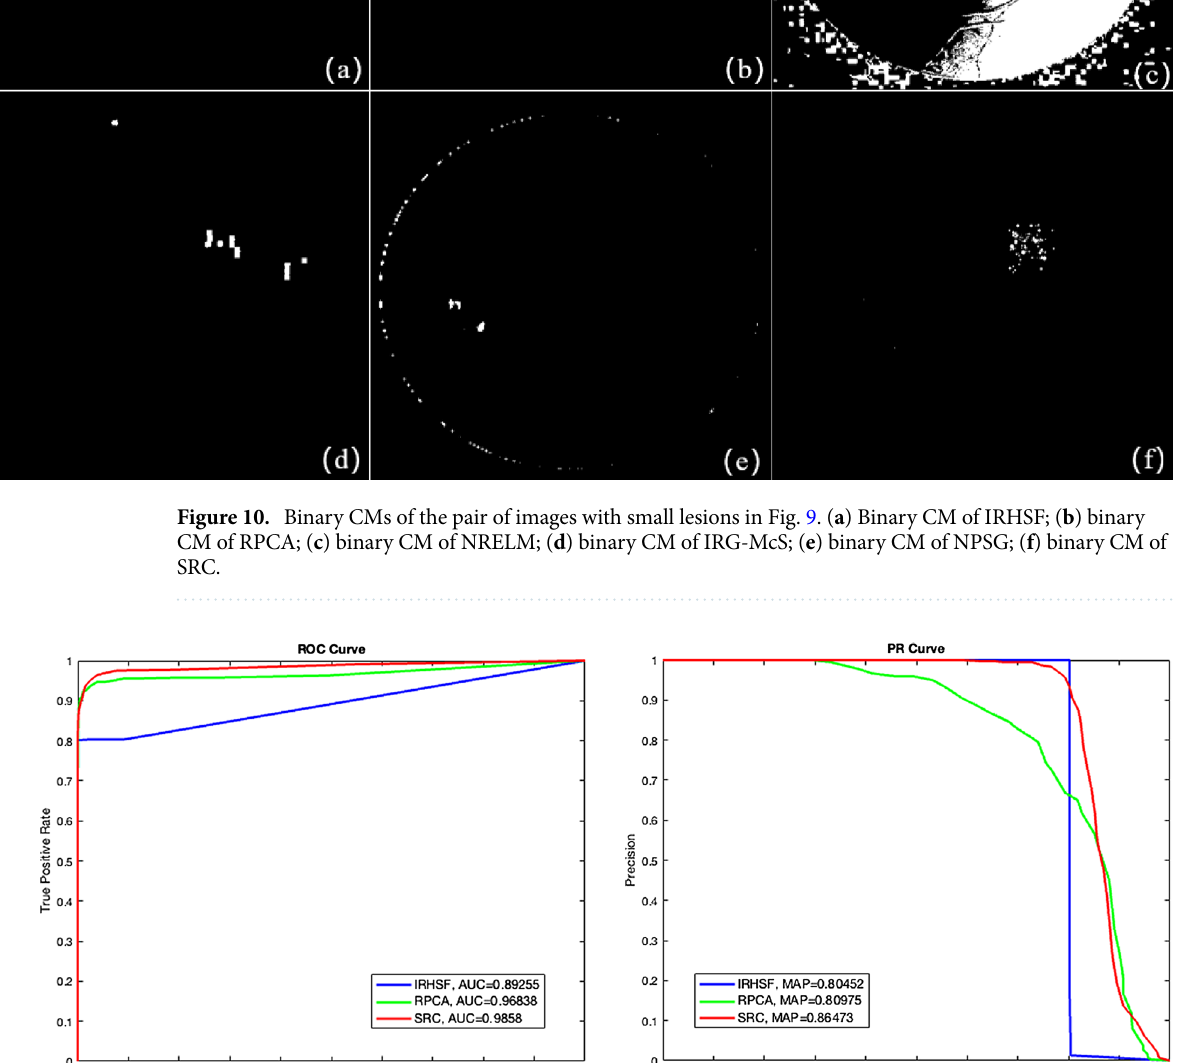
any size is the next work of this paper.